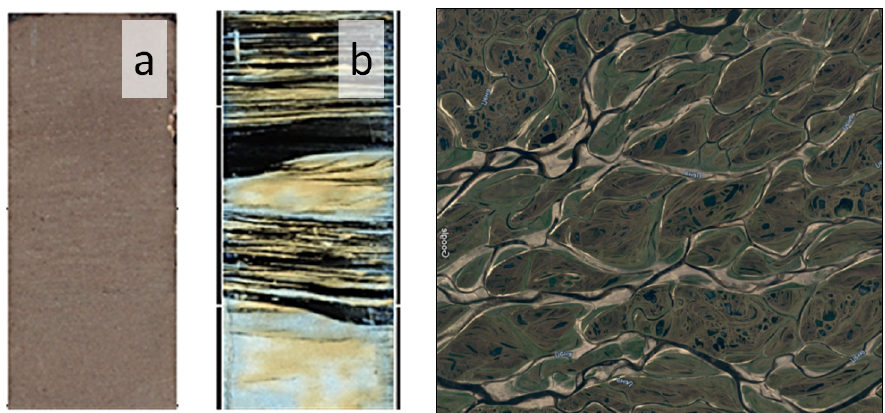
Figure 1. Left part—Snapshot of core rock ( a )—weakly consolidated highly permeable sandstone of “channel” facies, ( b )—interbedding of heterogeneous argillaceous sandstone of the “floodland” facies), Right part represents sedimentary environment [18].